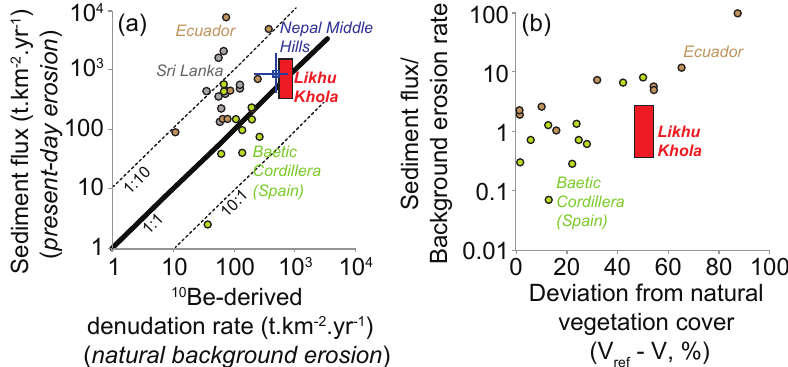
Figure 4. (a) Comparison of short-term erosion rates from sediment fluxes and long-term denudation rates from 10 Be concentrations in quartz from river sediment, from mountain catchments in different settings all with significant agricultural land use. The red box shows range of 10 Be qtz -derived rates for Bore Khola determined in this study, compared to sediment fluxes from the Bore in 1992 (Brasington and Richards, 2001). The light-blue point shows the median ± 68% confidence interval of the data set on 10 Be qtz denudation rate and sediment flux from other catchments in the Nepal Middle Hills (note that these data are not from paired catchments and that the sediment fluxes are highly uncertain; see text and Tables S1, S2). The Nepal data indicate little increase in present-day sediment fluxes above background denudation rates, in contrast to the large increases in present-day rates observed in many catchments in Sri Lanka (gray points; Hewawasam et al., 2004) and Ecuador (brown points; Vanackar et al., 2007), but similar to many agricultural catchments in the Baetic Cordillera of Spain. (b) Comparison of the present-day enhancement of erosion rate to the extent of anthropogenic disturbance of native vegetation. The data from the Likhu Khola indicate less enhancement of erosion for a given change in vegetation cover compared to catchments in Spain and